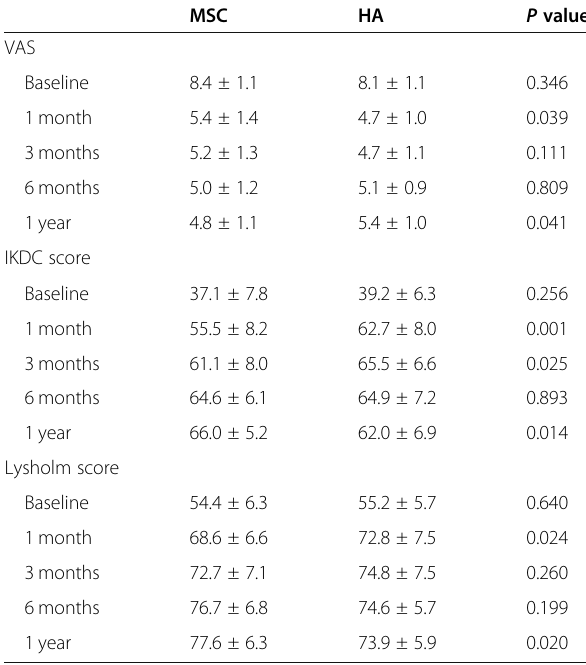
Table 2 Comparison of preoperative and postoperative clinical